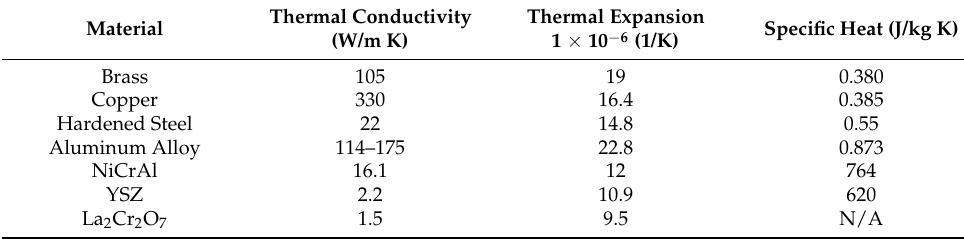
Figure 3. ( a ) AHB and nozzle CAD model; ( b ) coated CAD model. Table 2. Thermal properties of the materials [16,17]. Table 2. Thermal properties of the materials